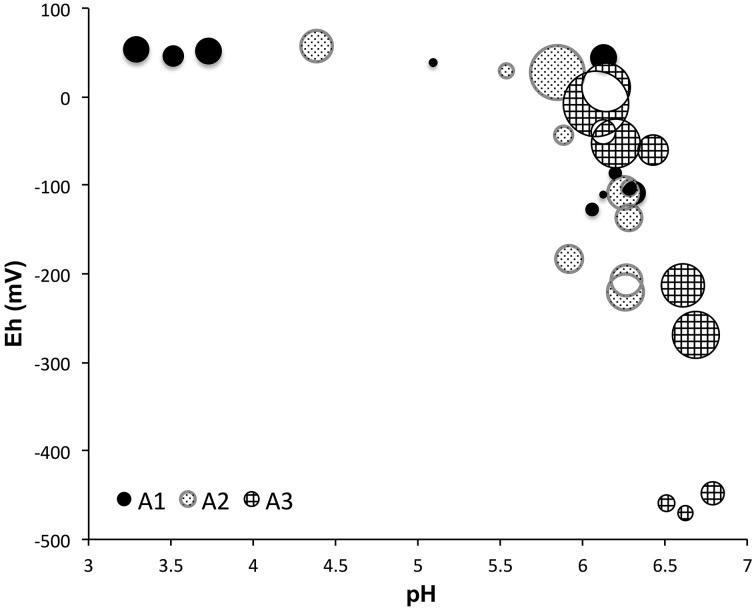
The alpha diversity (inverse Simpson) vs. pH and Eh values among three sampling sites, the diversity values are proportional to the area of bubbles. The more positive Eh values indicate more oxidized environments. Diversity showed significant difference among three sites (P < 0.01, ANOVA).